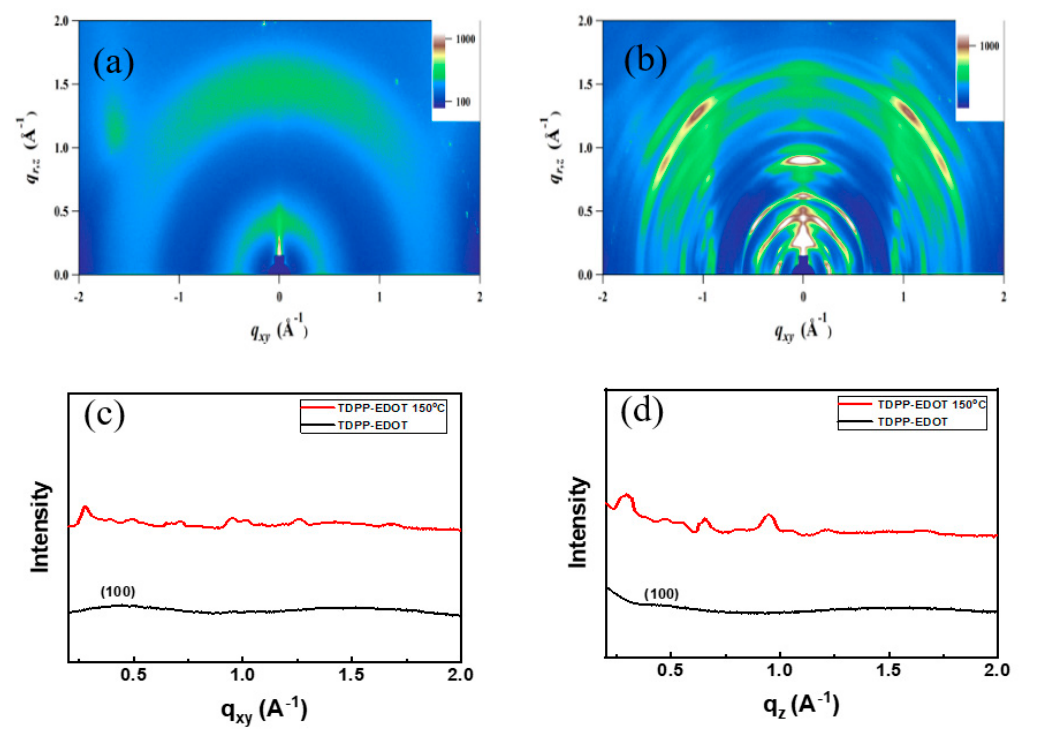
Figure 6. Two-dimensional grazing incidence X-ray diffraction images of TDPP-EDOT ( a ) without annealing and ( b ) with being annealed at 150 °C, corresponding line-cuts along the ( c ) q xy and ( d ) q z plane.